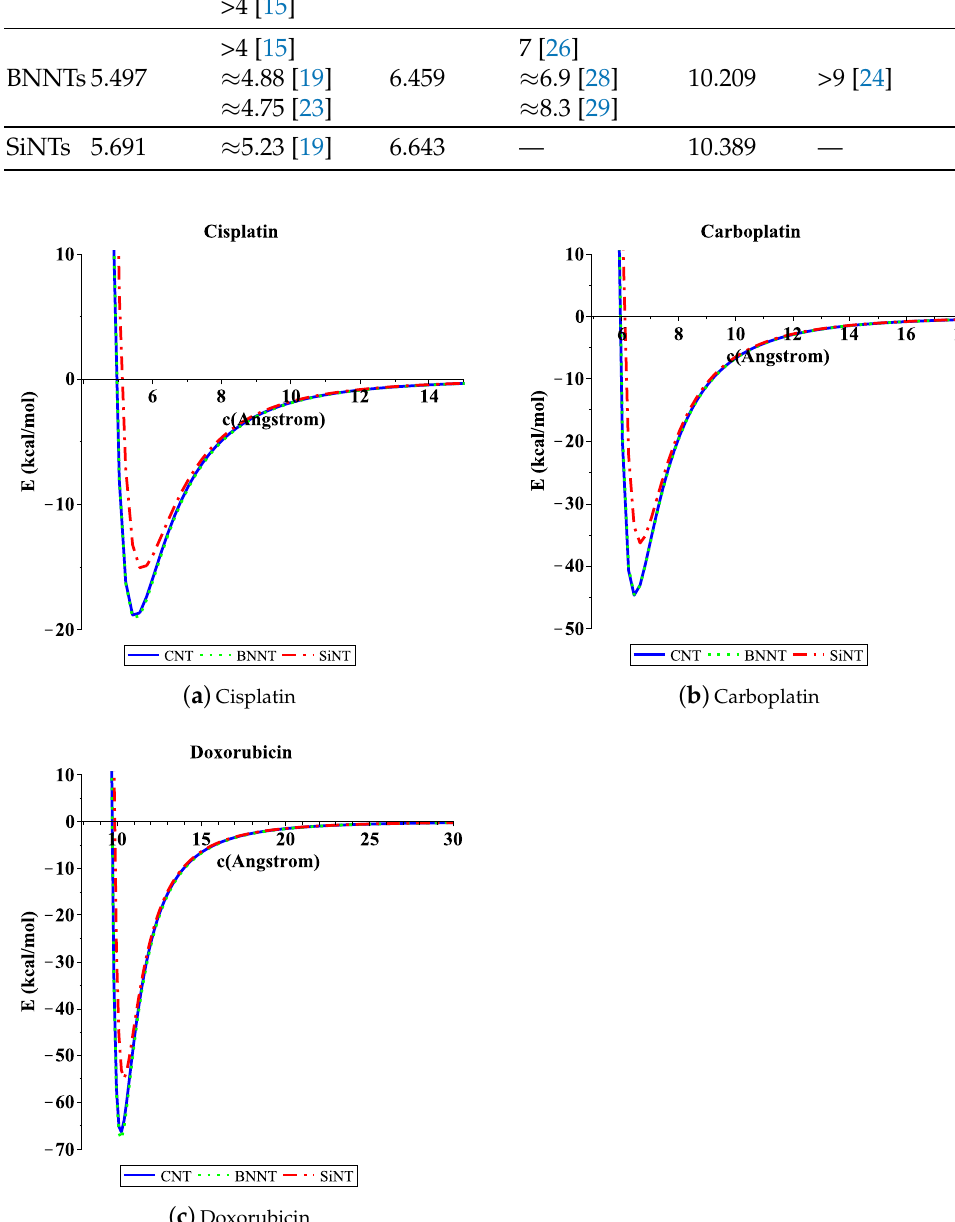
Figure 3. Total potential energy for each drug molecule inside CNTs, BNNTs, and SiNTs with a radius of c